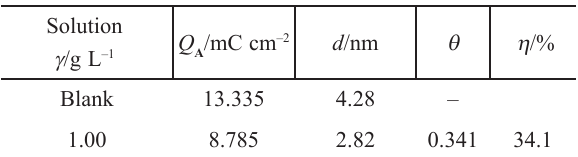
Table 3 – Anodic charge, thickness of oxide film, surface coverage, and inhibition efficiency calculated from data shown in Fig. 2